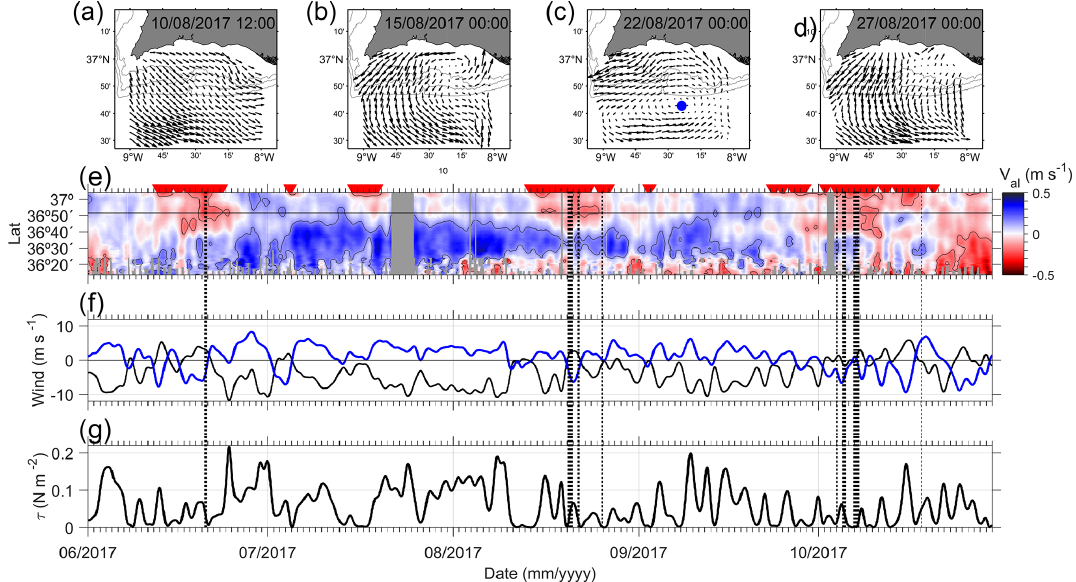
Figure 15. Example of the cyclonic circulation evolution over the western region (a–d) and the detected cyclonic eddy centre (indicated by the blue dot in c ). Hovmöller diagram of filtered V al extracted at TrW (e) . Red triangles on top represent recirculation periods identified based on EOF criteria (mode 2 phase between − 65 and 65 ◦ and ratio of mode 1 and mode 2 amplitudes ≤ 2). Filtered ERA5 wind averaged at the box − 9 ◦ E, − 7 ◦ E, 36 ◦ 45 (cid:48) N and 37 ◦ N and black and blue curves representing the meridional and zonal components respectively (f) . Wind stress magnitude (e) . Black dotted vertical lines indicate periods when a cyclonic eddy was detected by the algorithm over the western bight. Major ticks represent the first day of the indicated month, and minor ticks represent 1d